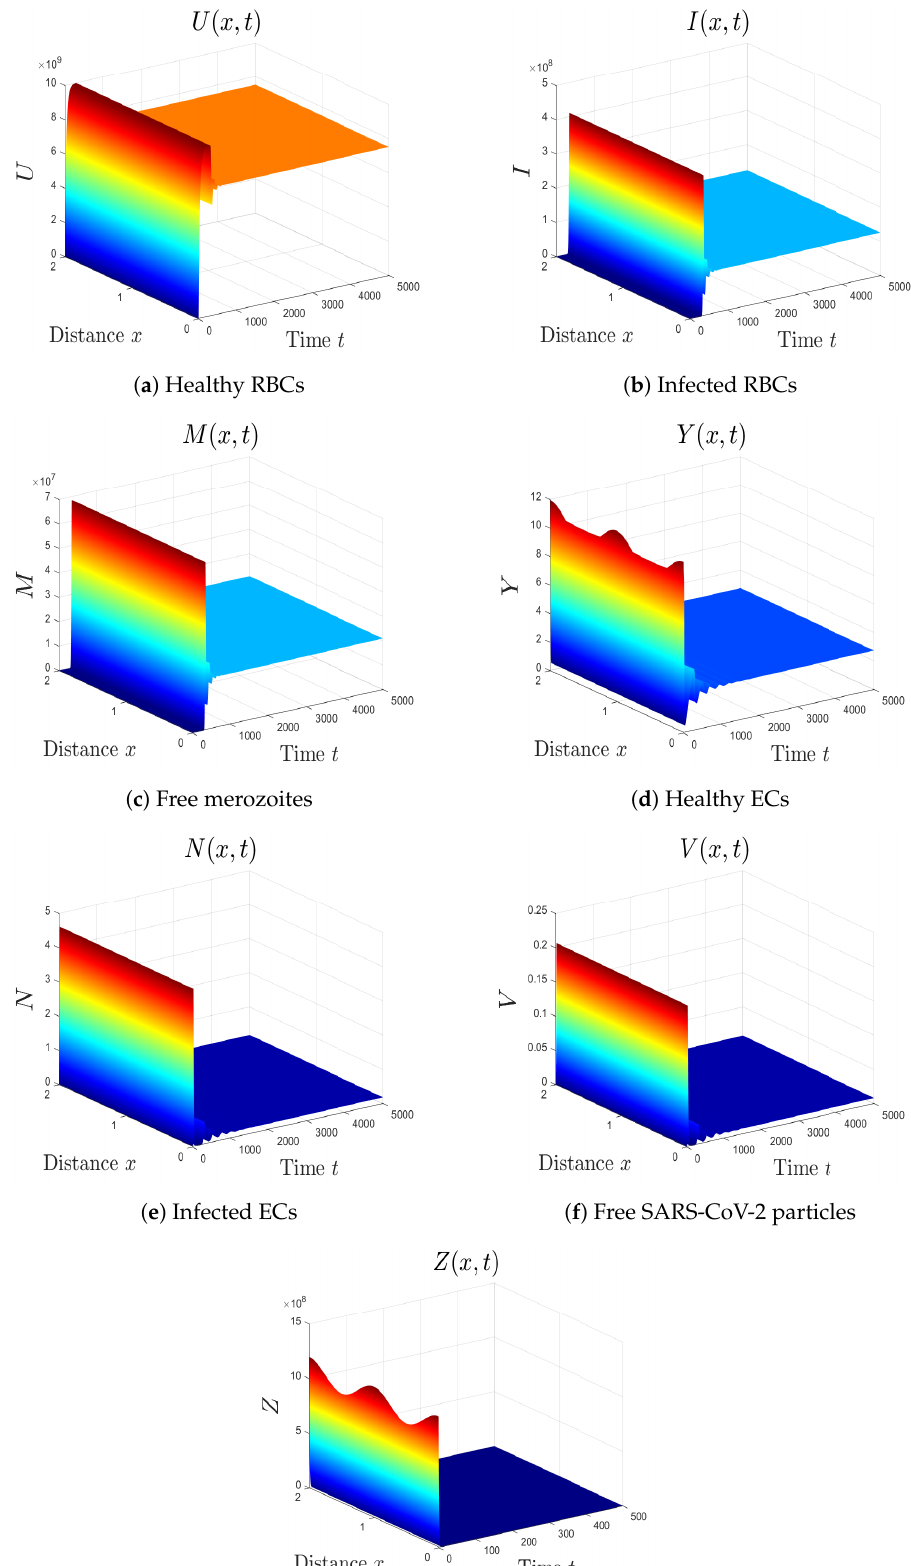
Figure 6. Simulation of system (1) for ( β m , β v , p 1 , p 2 , d 7 ) = ( 4 × 10 − 10 ,0.9,3 × 10 − 8 ,0.96,0.8 ) . The equilibrium E 5 = ( 7.5 × 10 9 ,1.25 × 10 8 ,2.08 × 10 7 ,2.73,0.1789,0.008,0 ) is